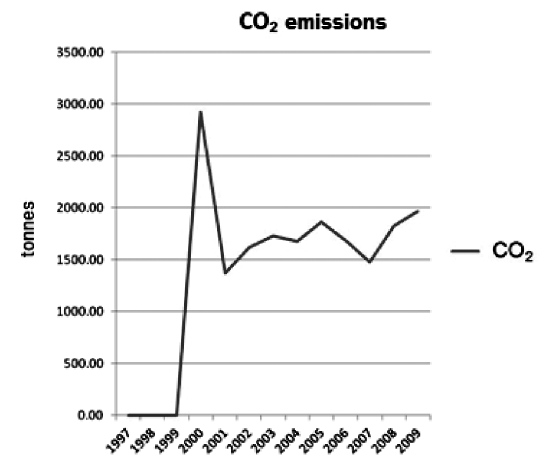
Fig. 5. Tallinn Airport gas-fired boiler house emission of CO 2 in tonnes (Keskküla 2012a)